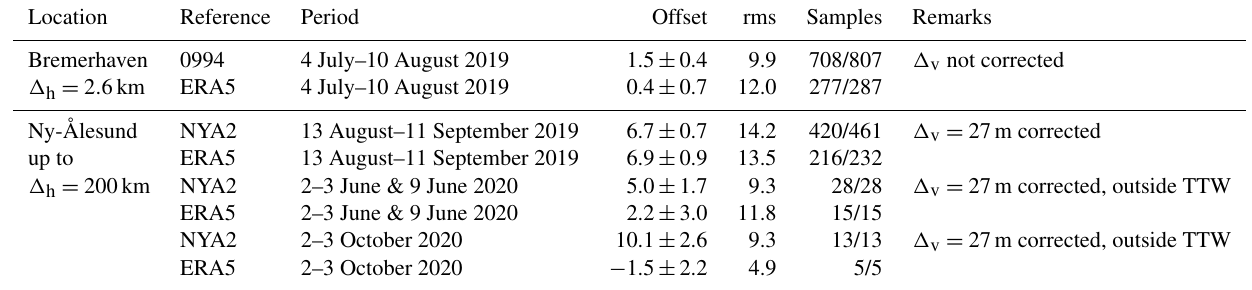
Figure 9. ZTD time series during the shipyard stay in July and August 2019: hourly ZTD values from RV Polarstern (black dots) and SAPOS station 0994 (blue), as well as ERA5-based ZTDs (green). Table 3. Summary of differences with respect to GNSS and ERA5 (always computed as the difference of RV Polarstern and the reference); (cid:49) h horizontal distance, (cid:49) v vertical difference; number of used/all samples is given; TTW indicates territorial waters; units: mm. Location Reference Period Offset rms